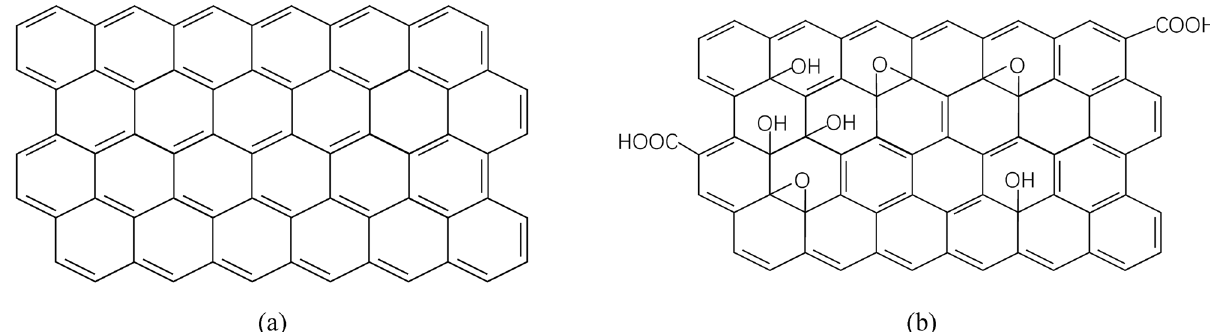
Figure 6: Structure of ( a ) graphene and ( b ) graphene oxide [ 71 ]